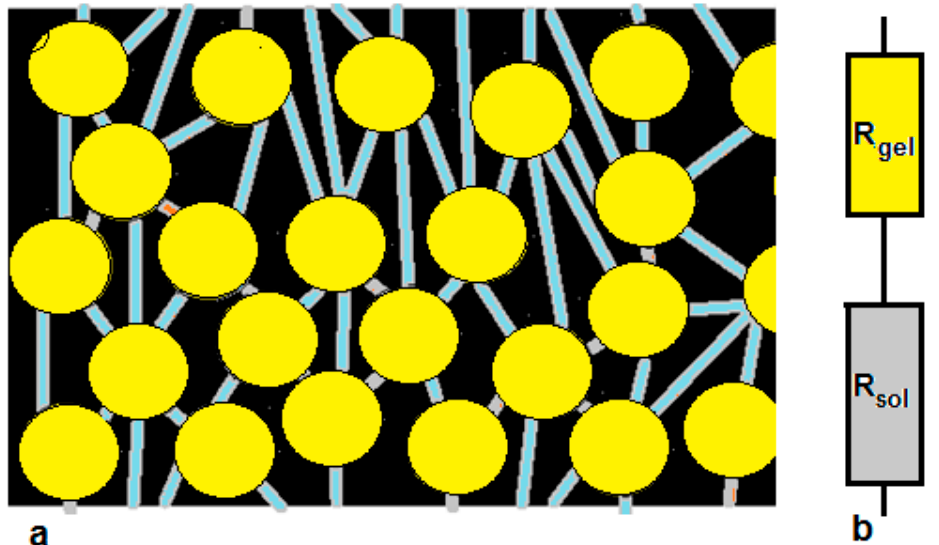
Figure 1. ( a ) Homogeneous ion exchange membrane. The small vesicles are filled with gel phase (yellow) containing fixed groups, water, and counter-ions, and a small amount of co-ions. The vesicles are interconnected by pores filled with water and dissolved ions (blue). ( b ) The one-thread model consisting of two resistances: R gel with a constant resistance and R sol with a concentration-dependent resistance [8].